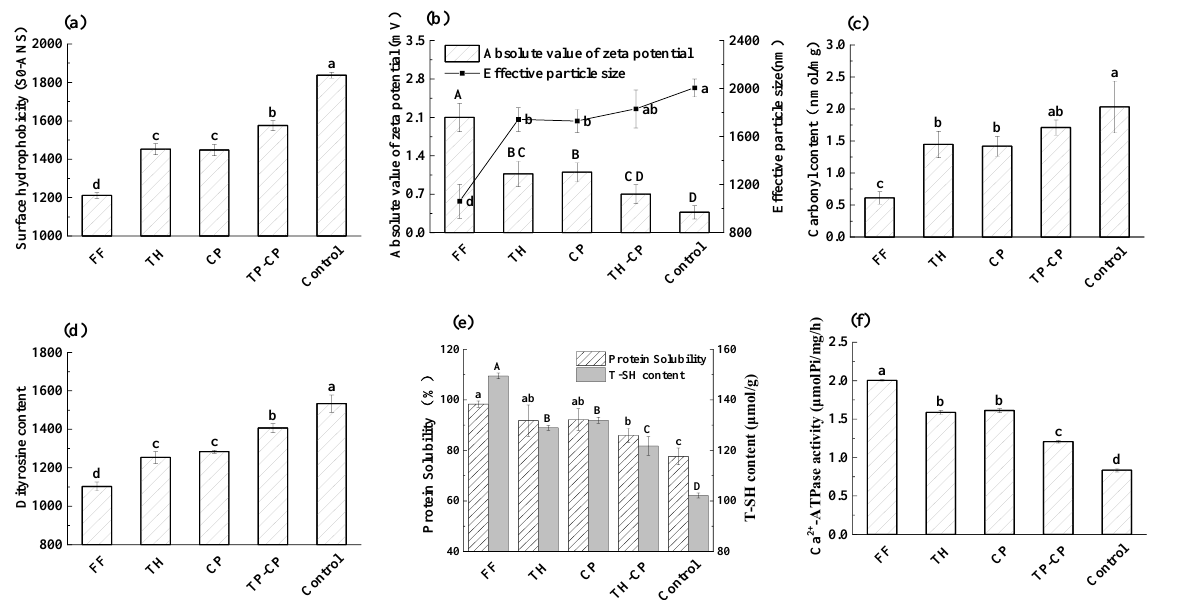
Figure 5. Effects of different treatments on ( a ) the surface hydrophobicity (So-ANS), ( b ) Zeta potential and particle size, ( c ) carbonyl content, ( d ) dimertyrosine content, ( e ) protein solubility, total sulfhydryl content, and ( f ) Ca 2+ -ATPase activity of MFP induced by freeze-thaw cycles. Note: In the significance analysis, the letters from a to d represent the values from large to small, and different letters represent significant differences ( p <